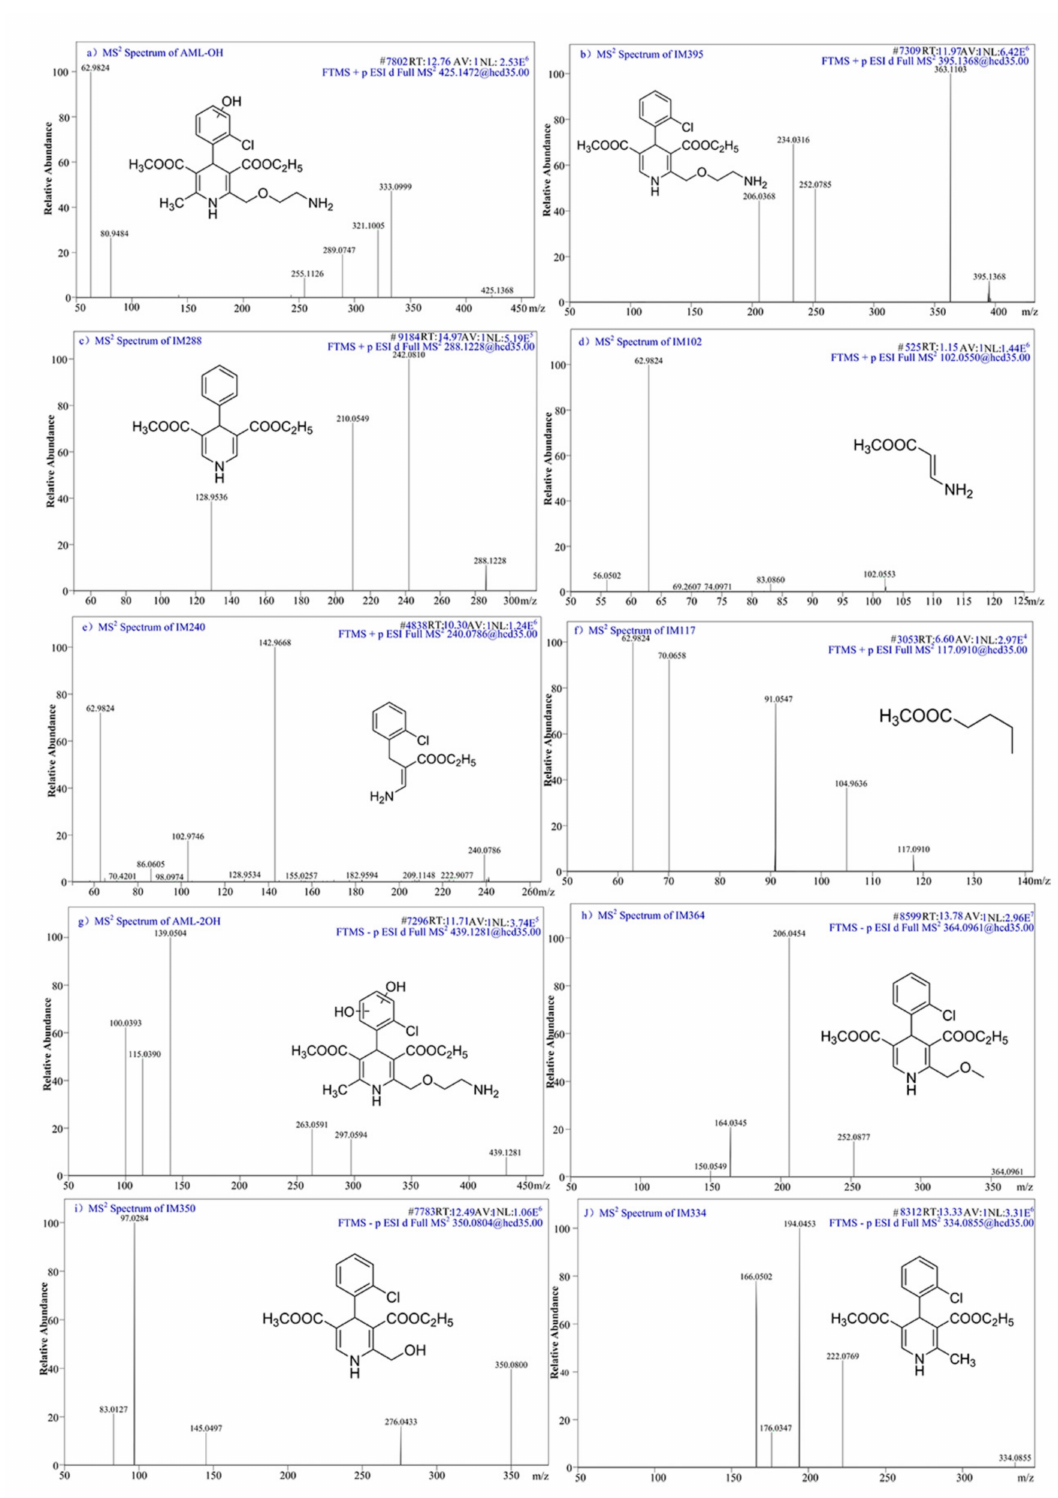
Figure A2. MS 2 spectra of intermediates obtained by HRMS. ( a ) MS 2 spectrum of AML-OH, ( b ) MS 2 spectrum of IM395, ( c ) MS 2 spectrum of IM288, ( d ) MS 2 spectrum of IM102, ( e ) MS 2 spectrum of IM240, ( f ) MS 2 spectrum of IM117, ( g ) MS 2 spectrum of AML-2OH, ( h ) MS 2 spectrum of IM364, ( i ) MS 2 spectrum of IM350, and ( j ) MS 2 spectrum of